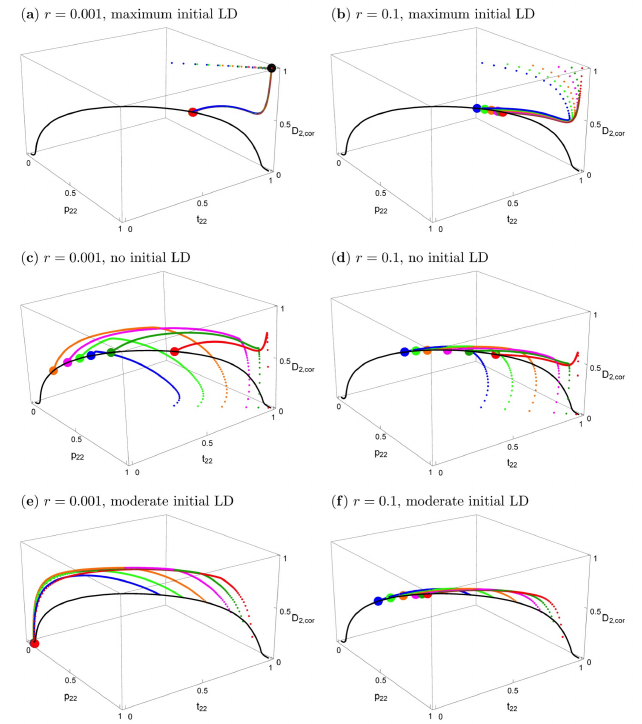
Figure 3. The effects of initial conditions and recombination rates on evolutionary trajectories when the trait is expressed in both sexes and migration is symmetric. Left column: r = 0.001; right column: r = 0.1. The other parameters are s 1 = s 2 = 0.2, α 1 = α 2 = 10, m 1 = m 2 = 0.01. The black curve is the curve of all stable equilibria. Small dots in different colors show evolutionary trajectories in population 2, starting from different initial values (see below). The bigger colored dots show the equilibrium that is reached. The big black symbol in panel ( a ) indicates the stable polymorphic equilibrium under phenotype matching ( r = 0). The vertical axis shows the correlation coefficient (cid:112) D 2, cor = D 2 / p 2,2 ( 1 − p 2,2 ) t 2,2 ( 1 − t 2,2 ) . In all panels, population 1 is initially fixed for P 1 and T 1 , and the trait allele T 2 has the following initially frequencies in population 2: t 2,2 = 0.99 (red), 0.95 (dark green), 0.90 (magenta), 0.80 (orange), 0.70 (light green), 0.60 (blue). In the top and middle panels, P 2 has the same initial frequency as T 2 ; there is maximum initial linkage disequilibrium (D 2,cor = 1) in panels ( a , b ), and no initial linkage disequilibrium (D 2,cor = 0) in ( c , d ). In ( e , f ), the initial values of the preference allele and the linkage disequilibrium are taken from the curve of stable equilibria that exists in allopatry (see main text). They are ( p 2,2 , t 2,2 , D 2 ) = (0.8695, 0.99, 0.0048) (red), (0.8279, 0.95, 0.0241) (dark green), (0.7766, 0.9, 0.0471) (magenta), (0.6768, 0.8, 0.0471) (orange), (0.5814, 0.7, 0.1123) (light green), (0.4909, 0.6, 0.1261) (blue). Abbreviations: LD, linkage